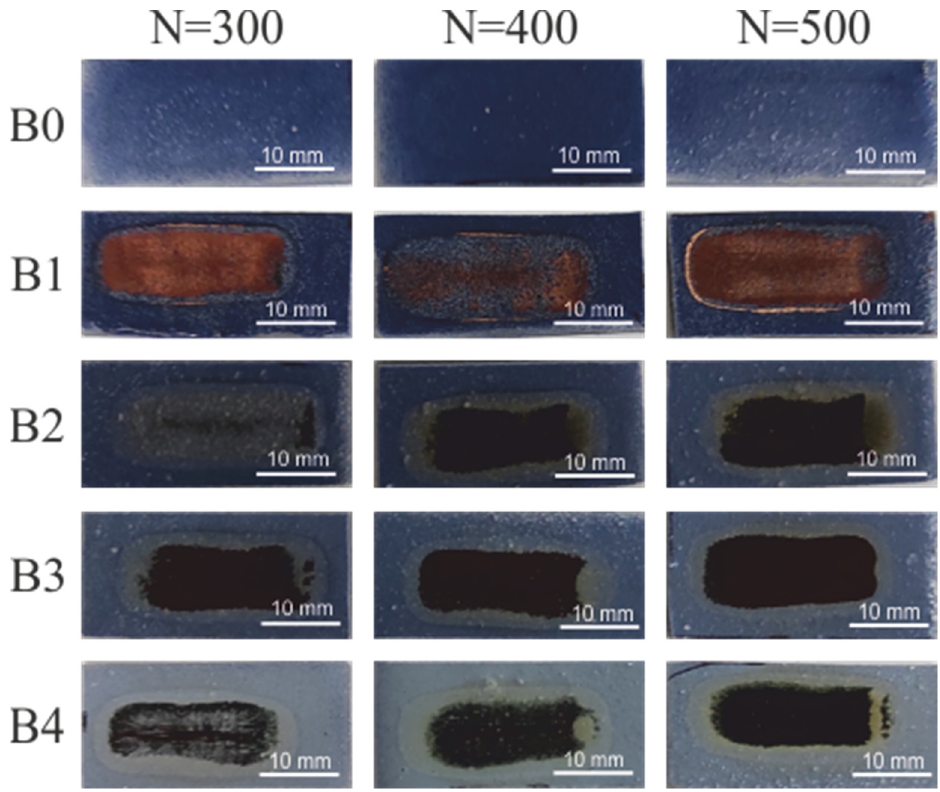
Figure 2. The effects of electroless metallization of B0–B4 coatings.